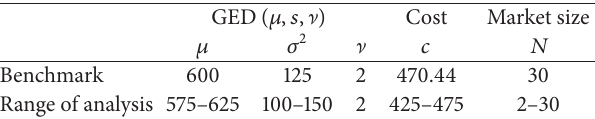
Table 1: Benchmark and range of analysis for price distribution parameters, cost, and market size.